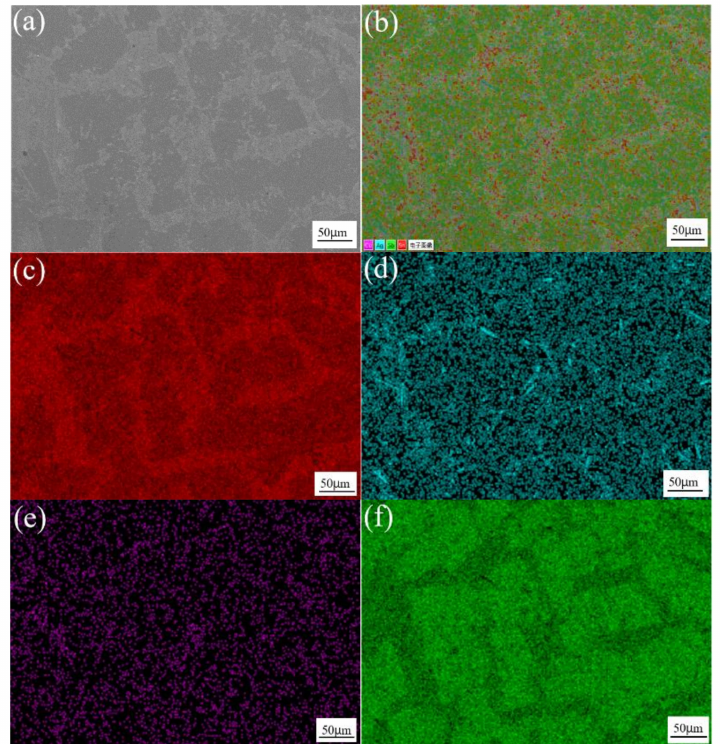
Figure 2. SEM image at 200x of Sn-3.0Ag-0.5Cu-25Sb ( a ); combined elemental map ( b ); and element distribution maps of Sn ( c ), Ag ( d ), Cu ( e ), and Sb ( f ).